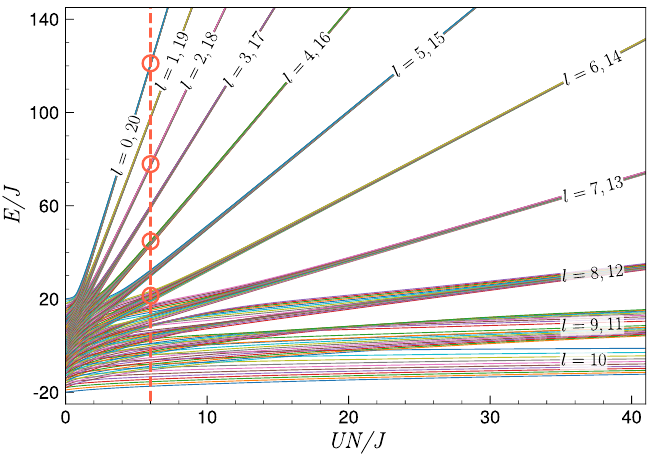
Figure 4: Energy level distribution. Dimensionless units are used. This figure is similar to Fig. 2, but displayed at a different scale. The labels shown on each band 〉 for states within the band. The vertical give the (approximate) possible values of 〈 N 2 line indicates UN / J = 6. The circles point out the four energy bands associated with the four initial states for the dynamics shown in Fig.